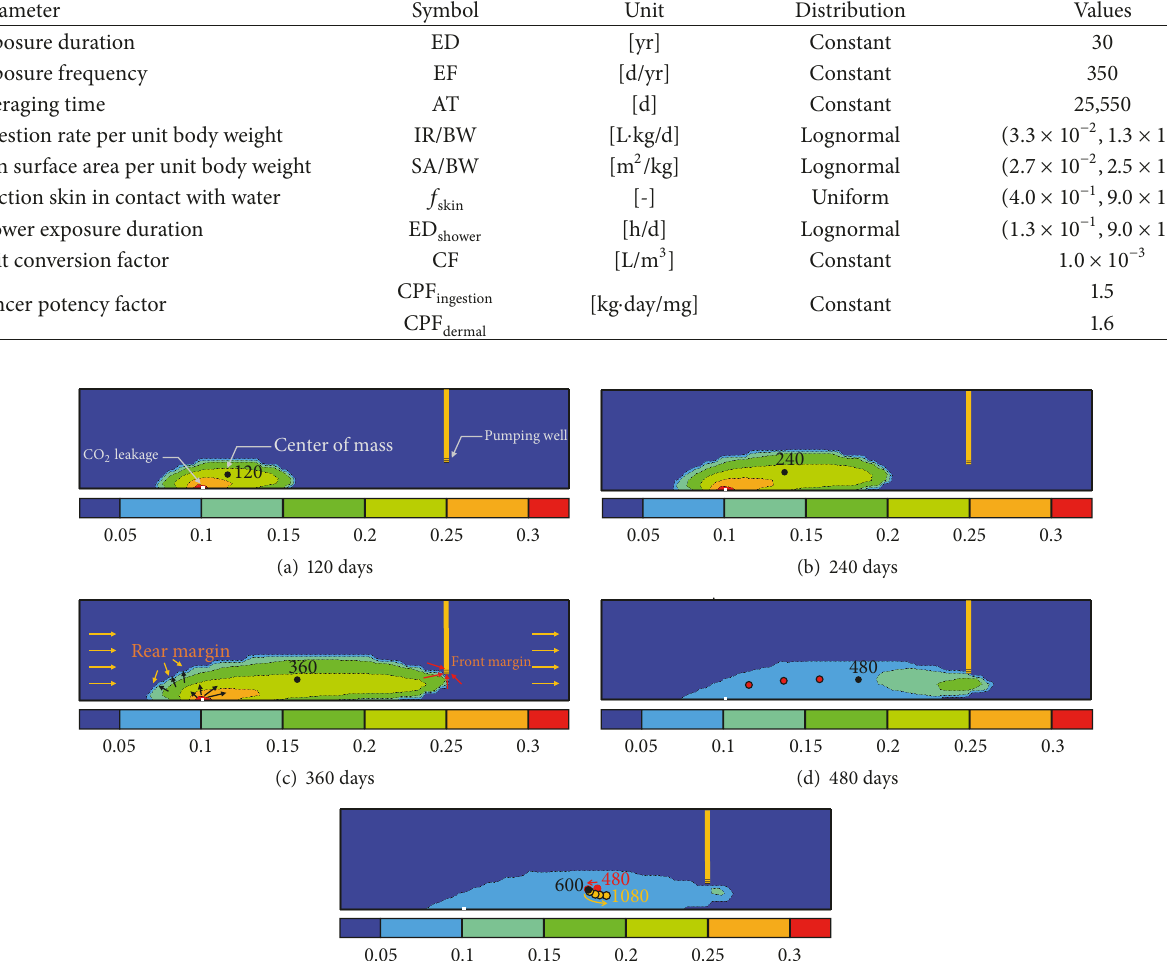
Table 5: Parameters for health risk assessment. Each parameter is randomly sampled within the designated value range and distributions to represent individual characteristics of potential victims.